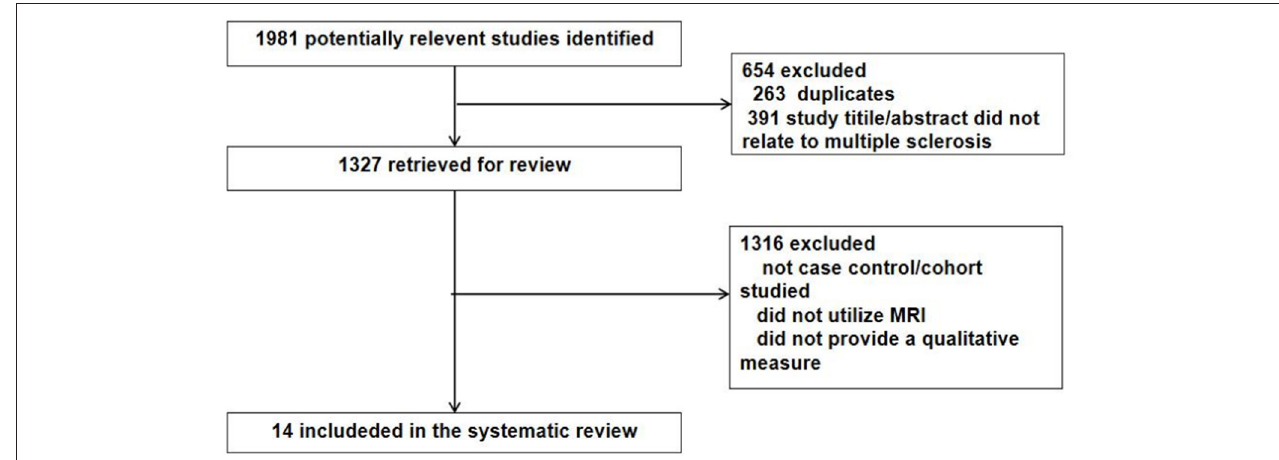
FIGURE 1 | Preferred Reporting Items for Systematic Reviews and